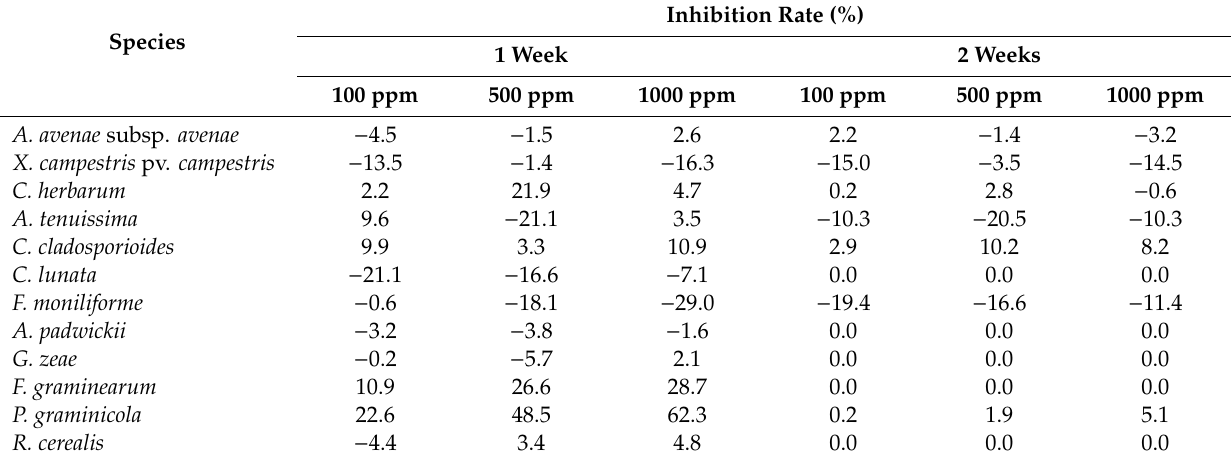
Table 2. Inhibition rate (%) of chrysoeriol 7 against various pathogen species.